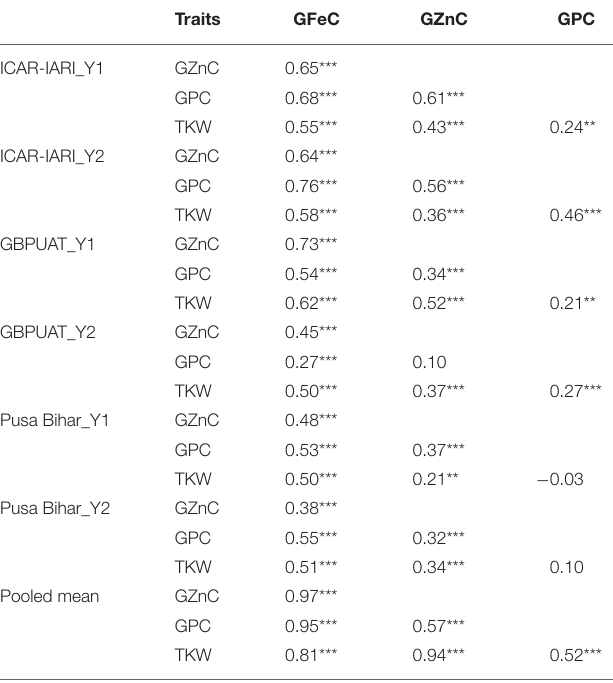
TABLE 2 | Genetic correlation coefficients among grain iron, zinc, protein, and thousand kernel weight in RIL population grown across three locations for 2 years. Traits GFeC